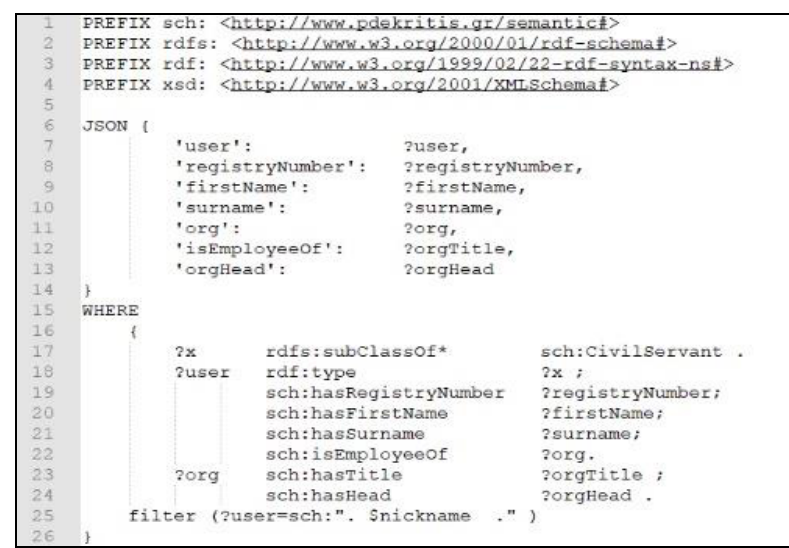
Figure 7. SPARQL query for retrieving employee’s and organization’s information.